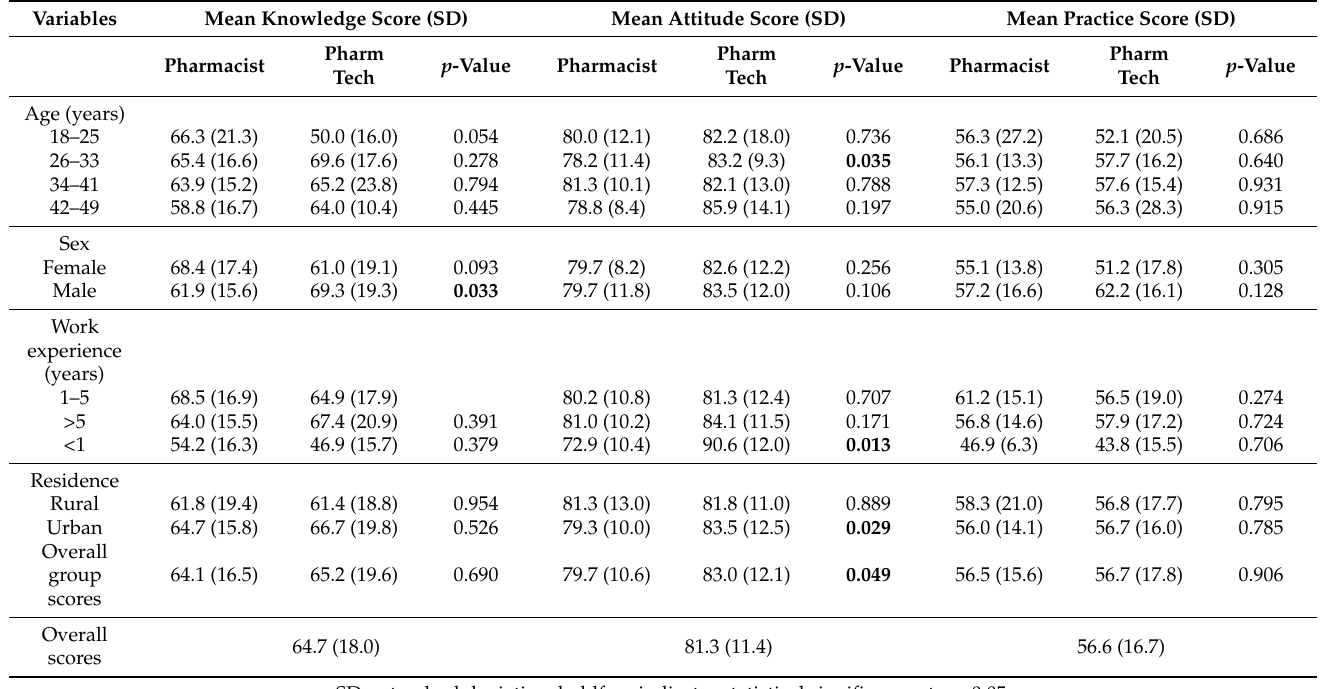
Table 3. Cross-tabulations: Socio-demographic characteristics and mean knowledge, attitude, and practice scores among pharmacists and pharmacy